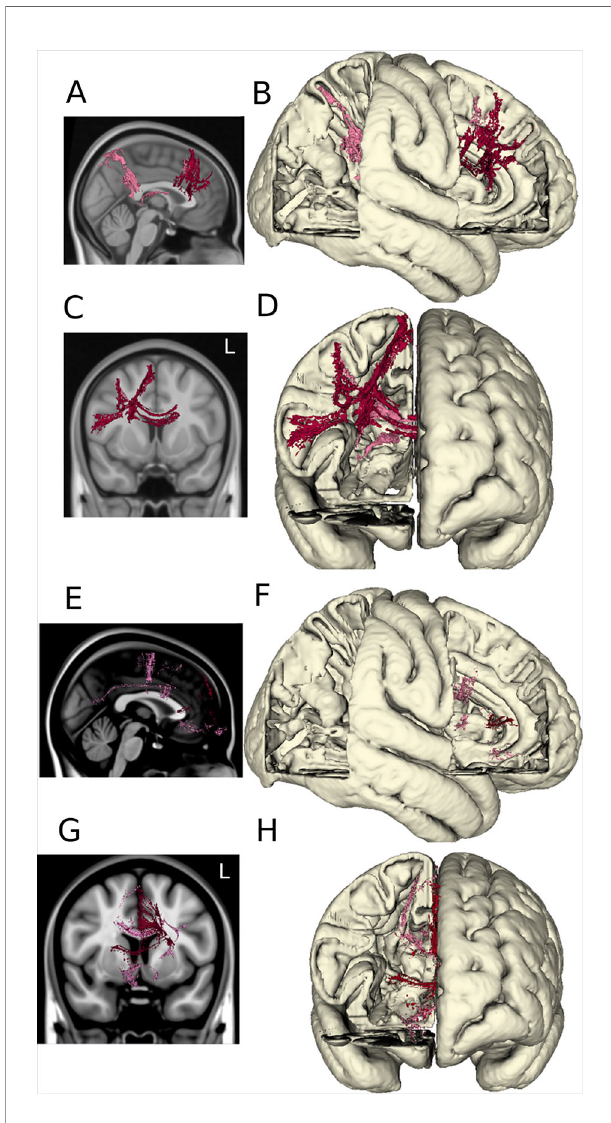
FIGURE 4 | DTI tractography. The probabilistic connectivity maps at optimal and optimal vs. suboptimal DBS settings are shown in sagittal and coronal projections with their respective 3D models. Panels (A – D) : Signi fi cant voxels associated with optimal DBS settings (bilateral lower middle contacts, low amplitudes). Panels (E – H) : Signi fi cant voxels comparing optimal vs. suboptimal DBS settings (bilateral lower middle contacts, high